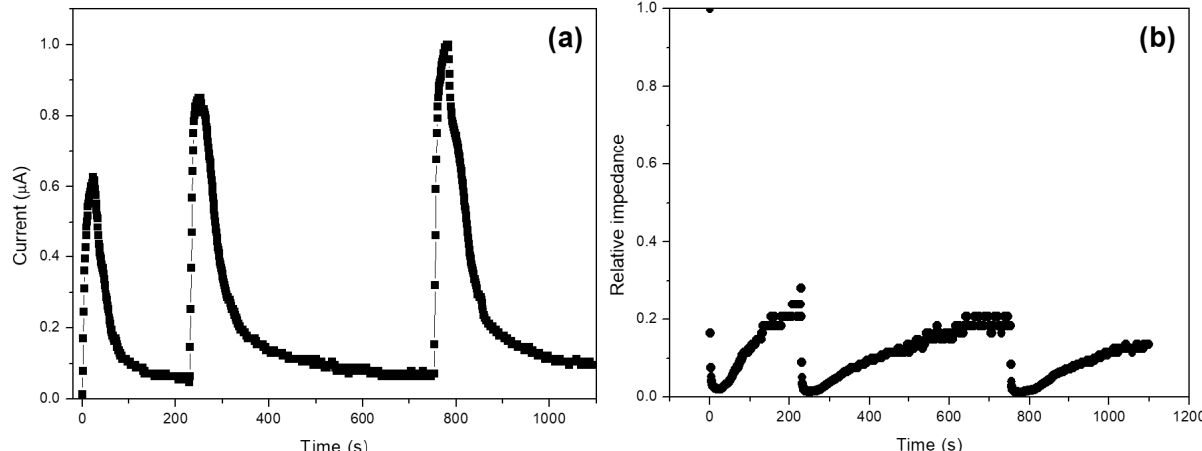
Figure 7. Exhalation signals displayed as time-resolved current intensity ( a ) and impedance ( b